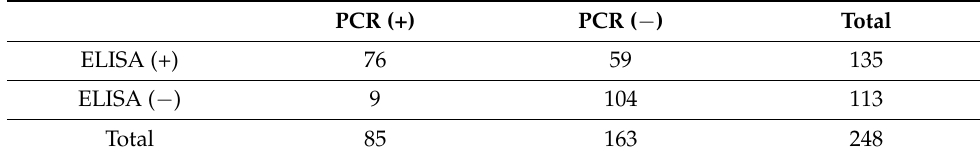
Table 3. Summary of ELISA and PCR results.